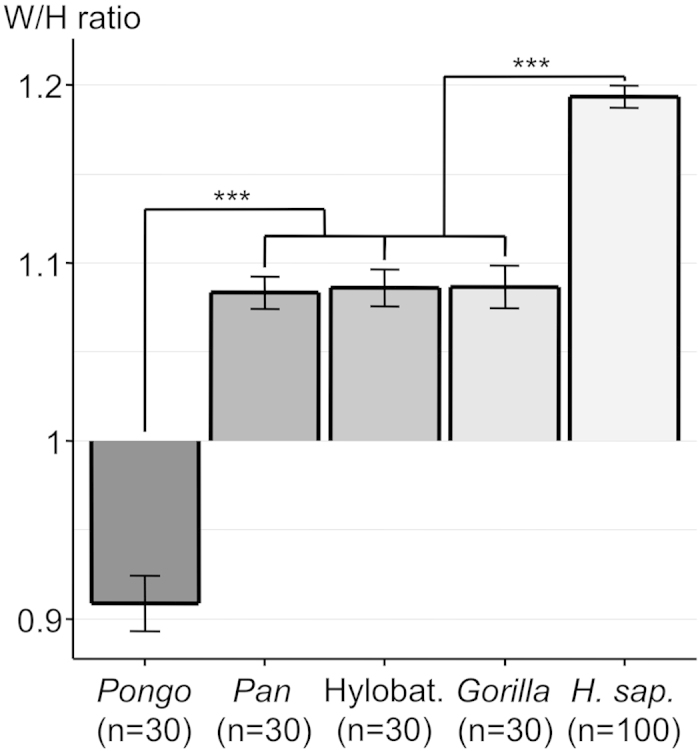
Histogram of orbital width/height (W/H) ratio (mean +/− SEM) of the different genera.***p < 0.001. Abbreviations used: Hylobat. = Hylobatidae; H. Sap. = Homo sapiens.